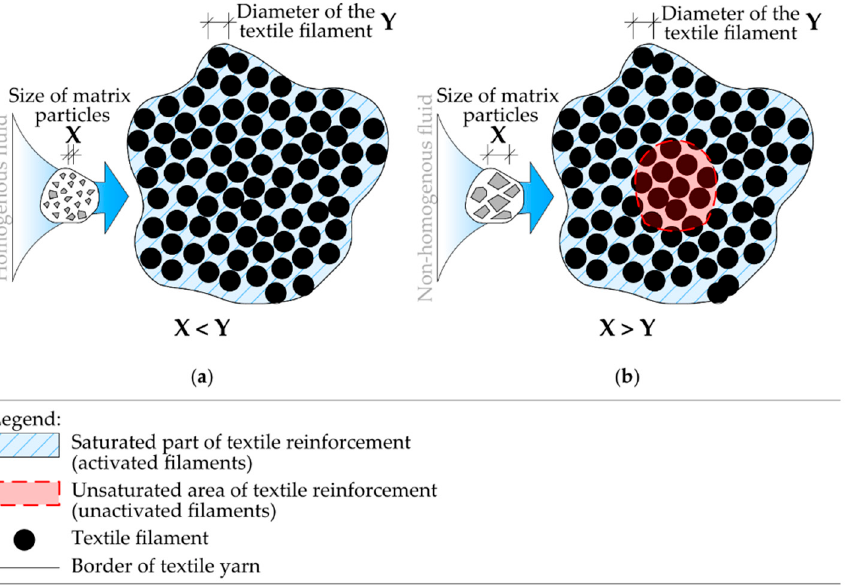
Figure 2. Scheme of tensile reinforcement saturation: ( a ) textile reinforcement penetrated by material with a homogenous structure such as epoxy resin—full activation of yarns is achieved; ( b ) textile reinforcement penetrated by suspension with particles larger than the filaments of the yarn—central part of yarn is not activated.